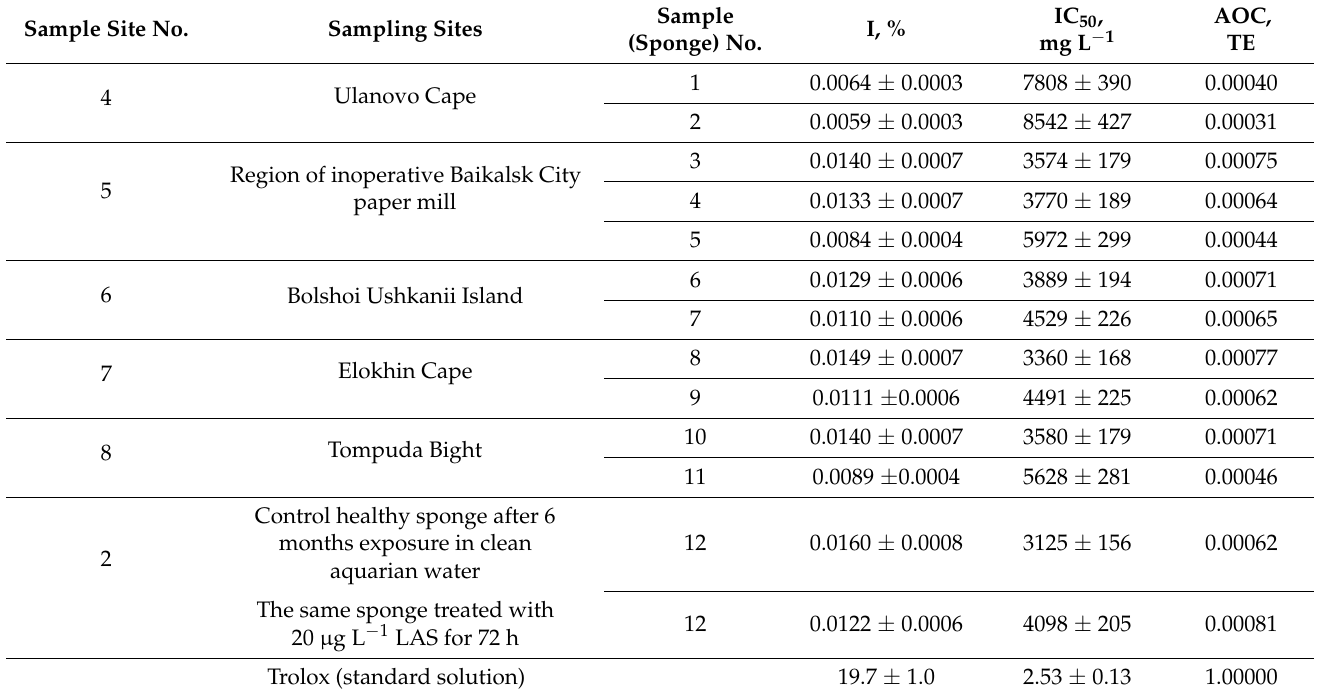
Table 3. Inhibition (I), half maximal inhibitory concentration (IC 50 ), and antioxidant activity (AOA) of L. baikalensis crude extracts and standard